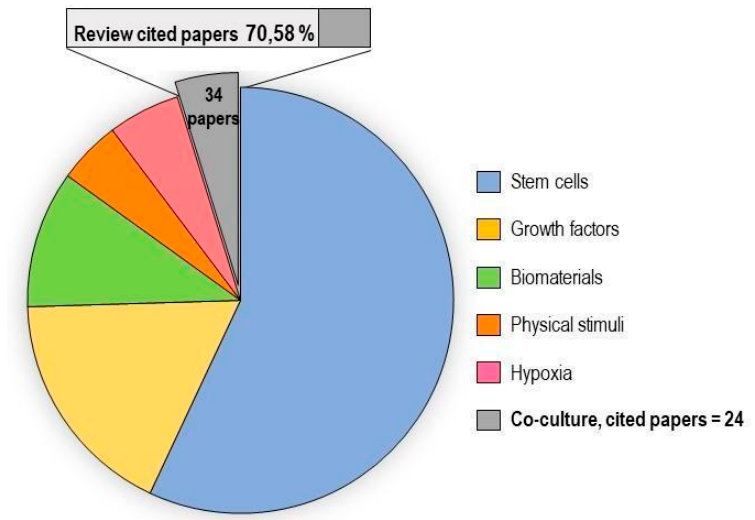
Figure 11. The gray section shows the percentage / number of papers available on the Scopus database obtained by combining key words in vitro stem cells tendon di ff erentiation with co-culture. In the histogram, the relative percentage of cited papers is expressed as well as the relative number in the legend.